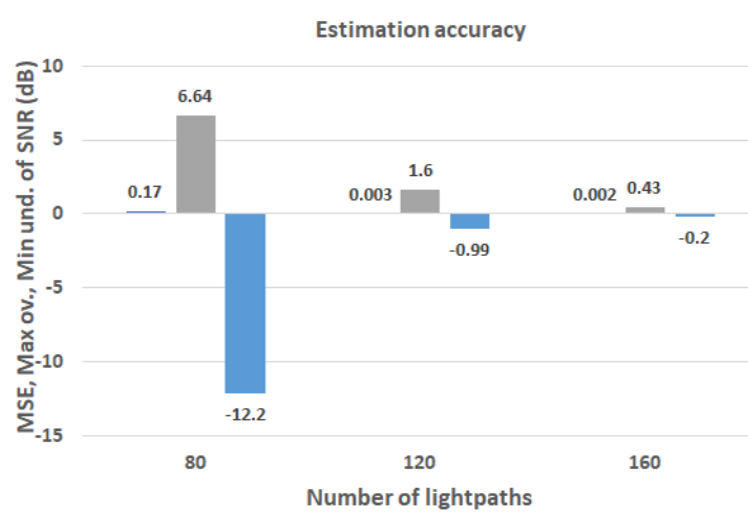
Figure 7. Signal-to-Noise Ratio (SNR) accuracy of the QoT estimator for various number of lightpaths (80, 120,